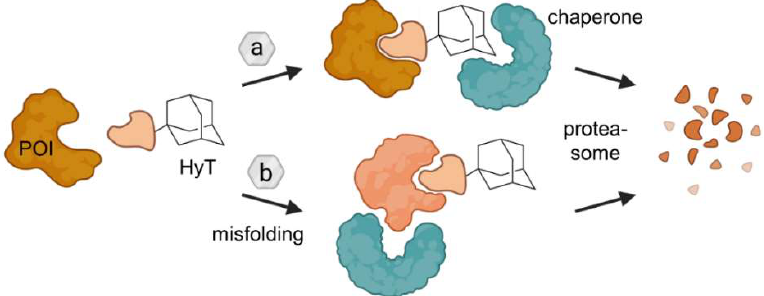
Figure 12. Ligands containing a hydrophobic tag (HyT) such as an adamantyl group bind the POI and induce its degradation through two putative mechanisms. Either HyTs mimic protein unfolding and recruit chaperones, which are responsible for protein quality assurance, and/or HyTs induce protein misfolding due to their bulky and hydrophobic nature. As a result in both cases, the POI is subjected to proteasomal degradation. Figure modified after Raina and Crews [46].